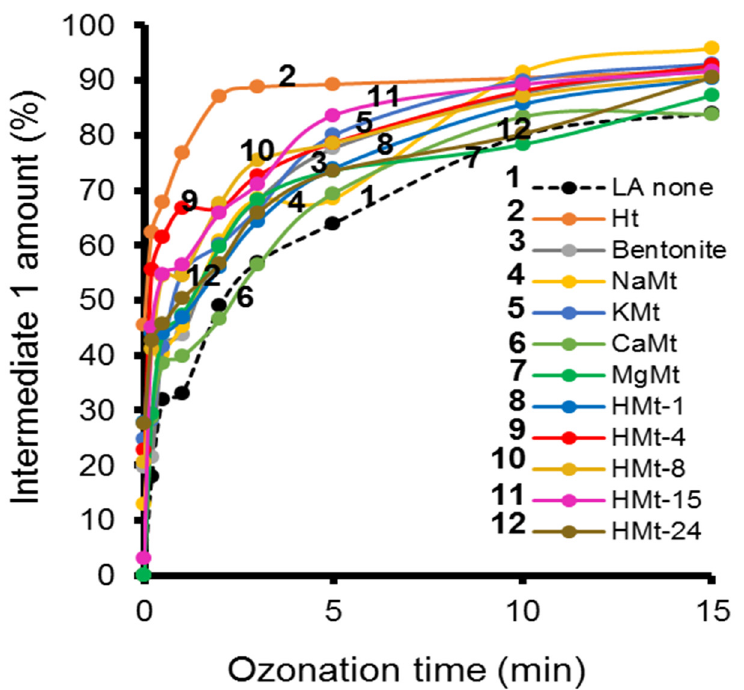
Figure 5. Evolution of the amount of intermediate-1 during ozonation in the presence of different catalysts as assessed by HPLC-UV. After ozonation, the sample was centrifuged and filtered with a 0.22 µm filter.